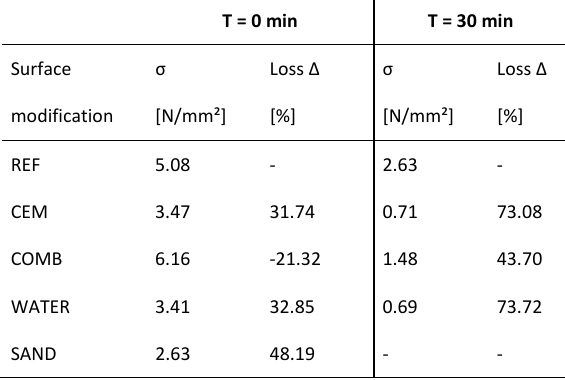
Table 5. Inter‐layer bonding strength and strength